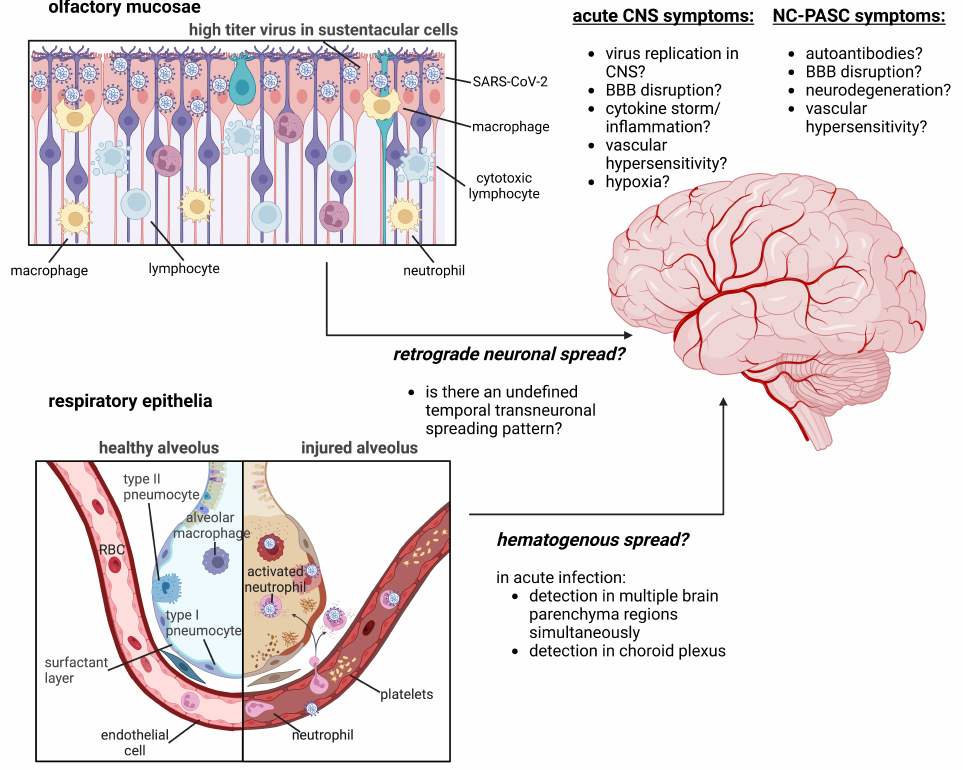
Figure 1. Summary of hypothesized pathophysiological mechanisms of NC-PASC development. Outstanding inquiries in the field concern the mechanism of SARS-CoV-2 neuroinvasion (direct neuronal infection via transneuronal spread through the olfactory mucosae versus hematogenous spread through transendothelial migration of infected leukocytes into the CNS) and the biochemical pathways that drive NC-PASC development and resolution. Figure was created with